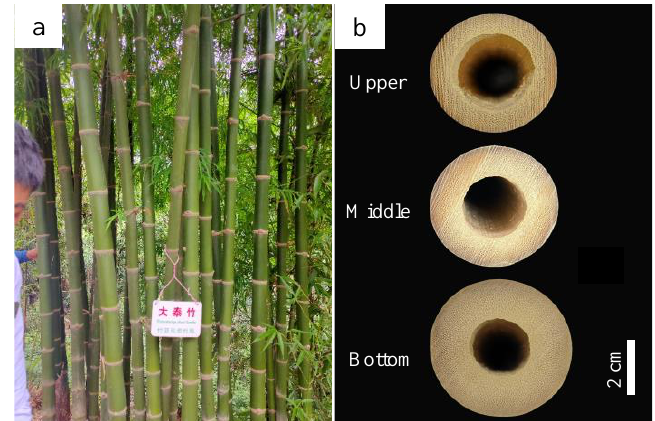
Figure 2. The culm morphological characteristics of the T. oliveri . ( a ) Appearance of culms below branches; ( b ) the cross section of the